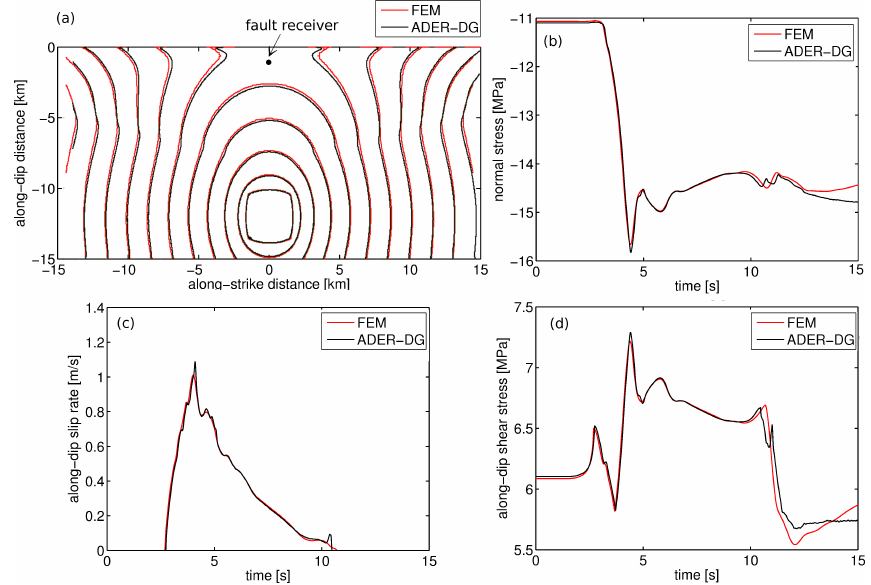
Fig. 2. Supershear and free surface effects in TPV11. (a) Rupture front contours on the fault plane every 0.5s. (b) Normal stress, (c) along-dip slip rate and (d) along-dip shear stress at an on-fault receiver located 0km along-strike and 1.5km along-dip. The ADER-DG solution is shown in black, the FEM comparison solution in red.